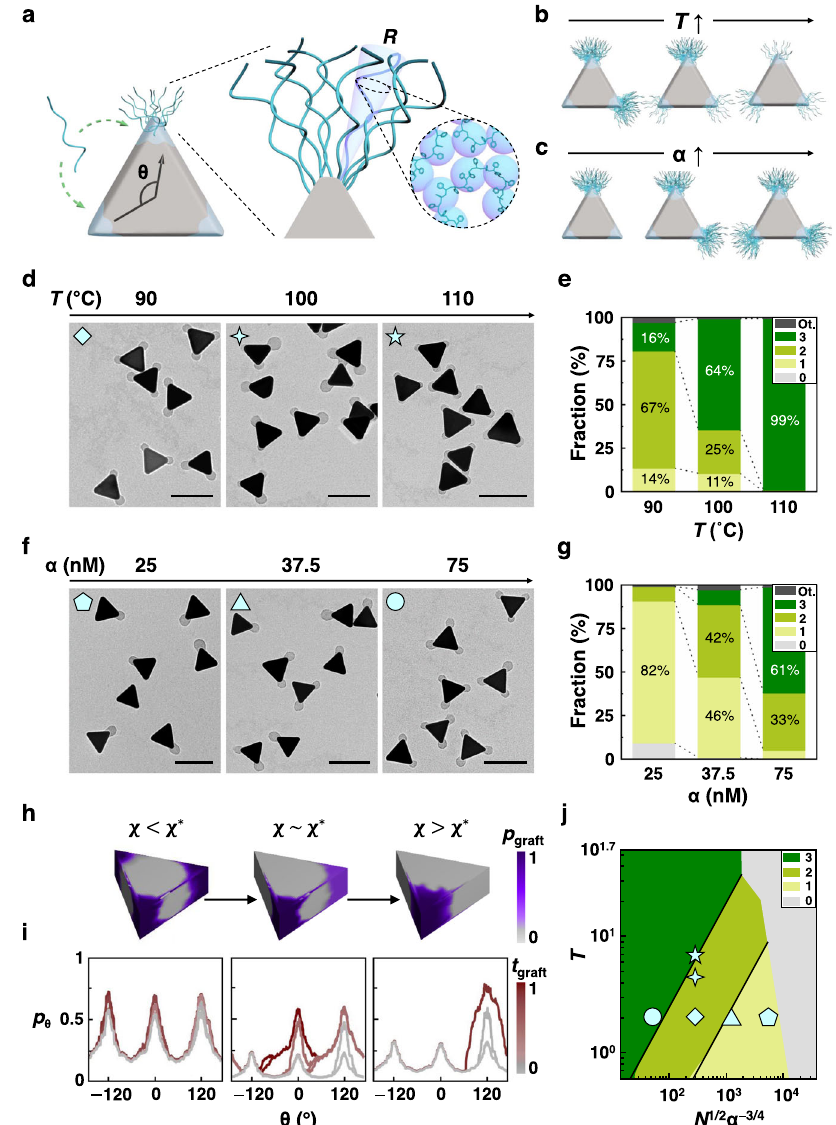
Fig. 2 | Quantitative control of the asymmetric grafting. a Schematic of the theoretical model of polymer chain grafting. Green dotted arrows (left) denote adsorption sites (tip area with the light blue shadows) on prisms for incoming polymer chains, either sites already occupied by other polymer chains or unoc- cupied. Zoomed-in view (middle) shows the theoretical model of grafted polymer chains(end-to-enddistance R )onthetipofprisms,asafunctionofsurfaceposition Ω . b , c Schematicsshowingtheeffectofincreasing( b )temperature T and( c )ligand concentration α , the ratio of 2-NAT molar concentration to the optical density of the prism suspension at its maximum extinction wavelength. d , f TEM images of patchy prisms at ( d ) increasing T ( α =50nM, fi xed) and ( f ) increasing α ( T =90°C, fi xed). e, g Histograms of NPs with the patch count n synthesized from the corre- sponding conditions presented in ( d ) and ( f ), respectively. Counted from 150 ‒